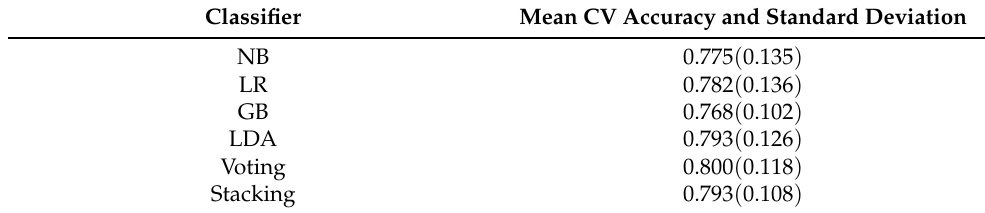
Table 10. Cross validation accuracy for the joint HV, LV datasets.